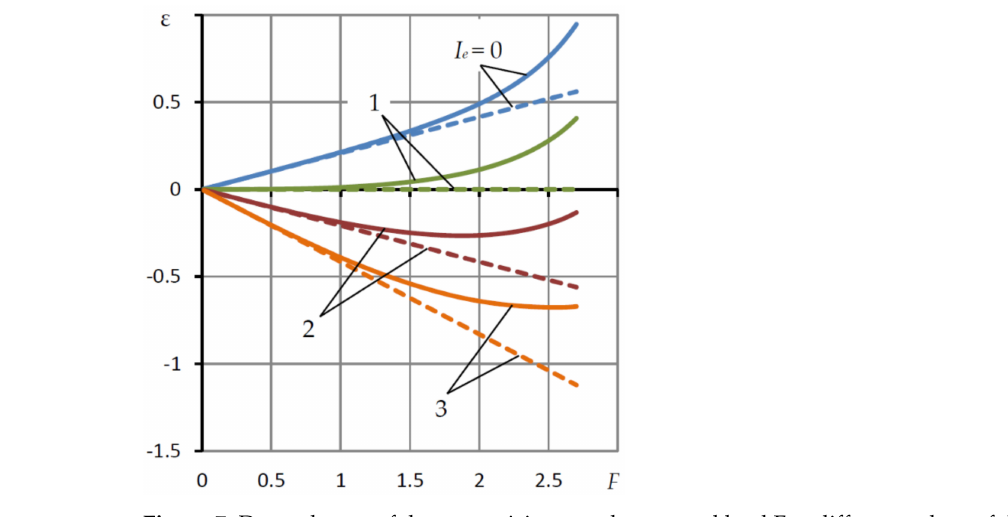
Figure 7. Dependences of the eccentricity ε on the external load F at different values of the elasticity coefficient K e .